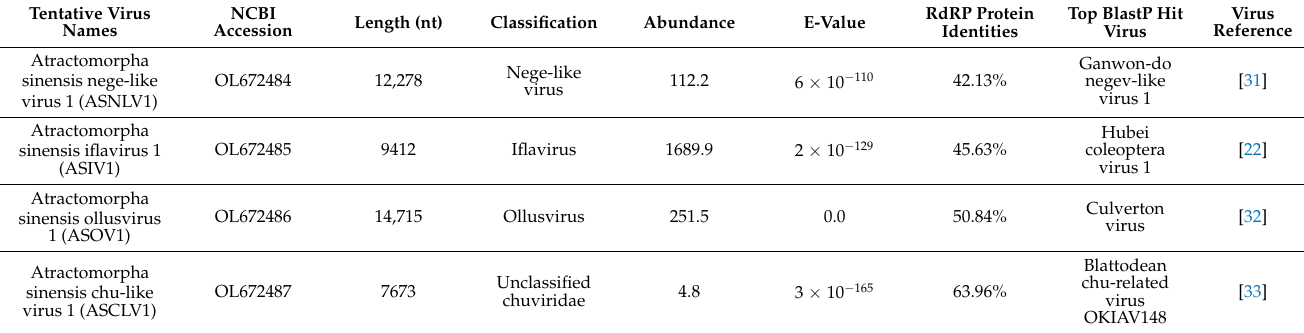
Table 1. The detailed messages about four novel viruses identified in Atractomorpha sinensis